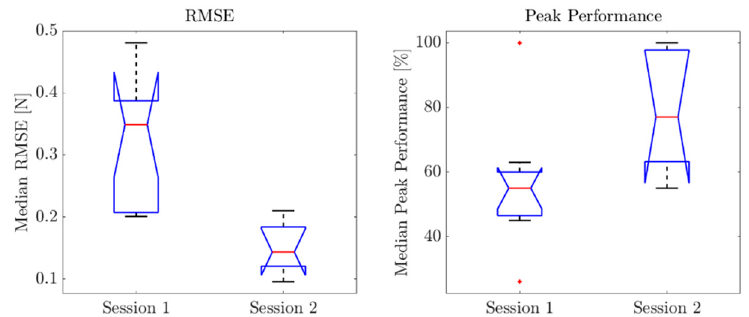
Figure 4 . Boxplots of RMSE and Peak Performance for session 1 (T0) and session 2